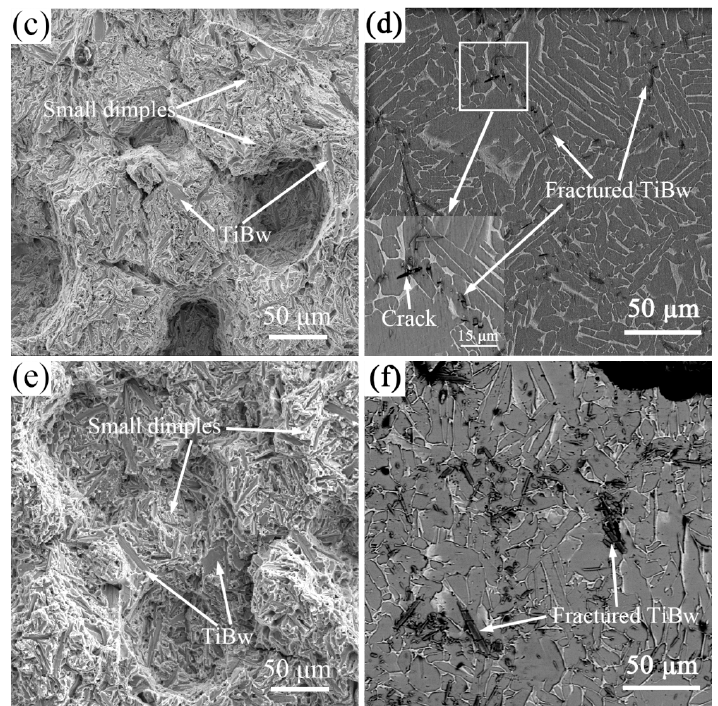
Figure 7. SEM images showing fracture surfaces and longitudinal sections of composites with different volume fractions of reinforcement: 0 vol % ( a , b ); 2.5 vol % ( c , d ); and 5 vol % ( e , f ); and fracture surface ( a , c , e ) and longitudinal sections ( b , d , f ).